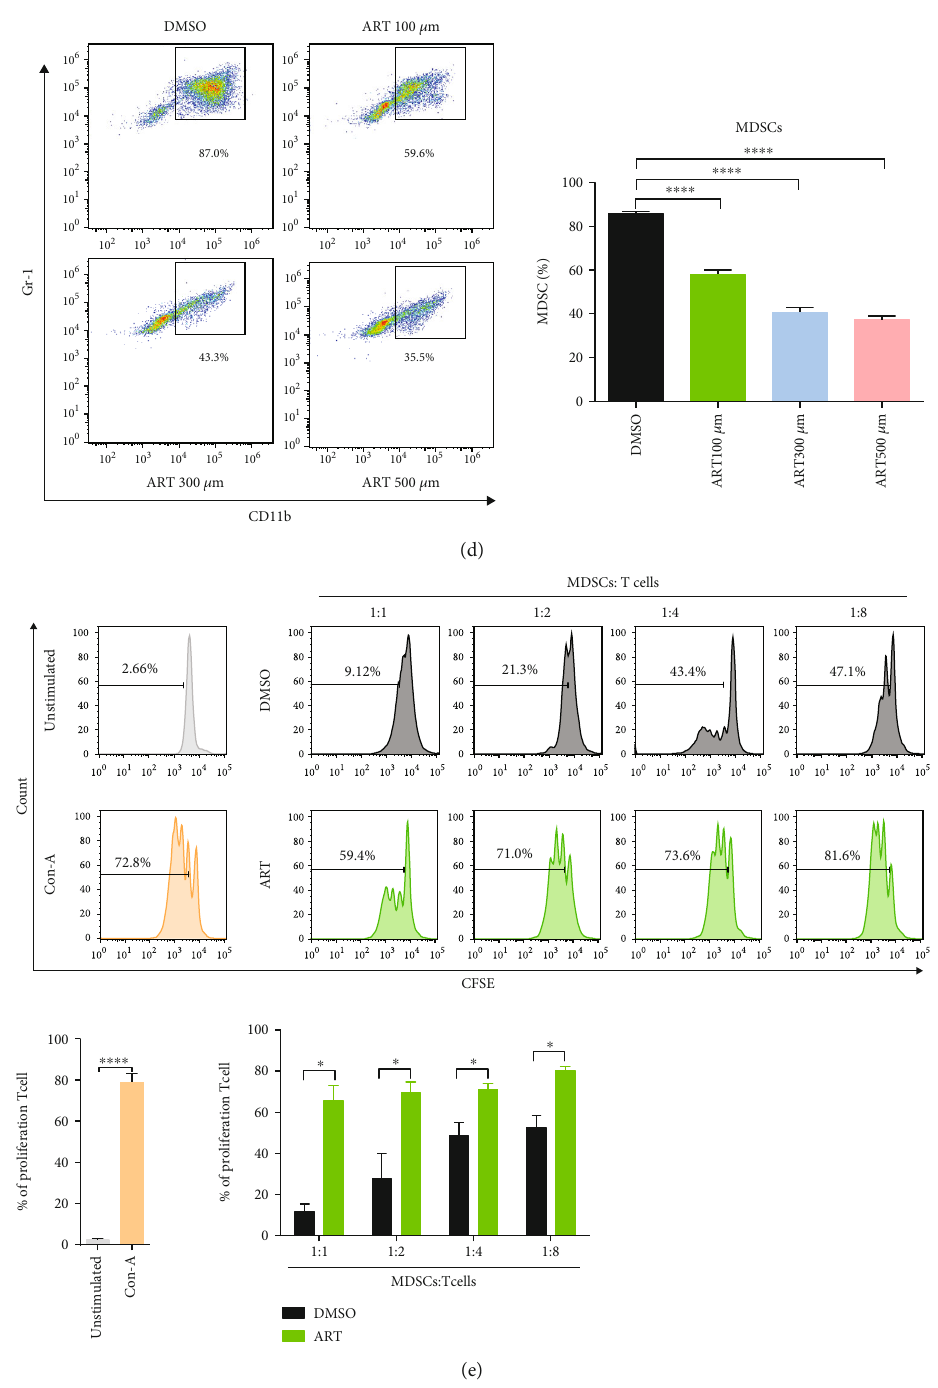
Figure 1: ART promotes MDSC apoptosis and inhibits the accumulation and immunosuppressive function of MDSCs. (a – e) Bone marrow (BM) cells isolated from wild-type C57BL/6 mice were cultured with GM-CSF and IL-6 for 3 days to generate in vitro BM-derived MDSCs and then were treated with di ff erent concentrations of ART (100 μ M, 300 μ M, and 500 μ M) for another 12 hours, and the solvent DMSO was used as the control. (a) The apoptosis levels of CD11b + Gr-1 + MDSCs were detected by fl ow cytometrical analysis. (b) The cleaved- caspase3, caspase3, p-RIPK3, and RIPK3 of CD11b + Gr-1 + MDSCs were detected by western blotting. (c) The DR5 mean fl uorescence intensity of CD11b + Gr-1 + MDSCs was detected by fl ow cytometrical analysis. (d) The proportion of CD11b + Gr-1 + MDSCs was detected by fl ow cytometric analysis. (e) Flow cytometry to purify CD11b + Gr-1 + cells from in vitro 100 μ M ART-treated BM-derived MDSCs and further cocultured CD11b + Gr-1 + MDSCs with Con A-stimulated CD3 + T cells isolated from the spleens of wild-type C57BL/6 at the 1 :1, 1 :2, 1: 4, and 1 :8 ratios to detect the percentages of proliferation T cells as tested by CFSE fl uorescence. Data are means ± SEM and are from a representative experiment of three (a – e) independent experiments. Unpaired Student ’ s < 0 : 05 , ∗∗∗ P < 0 : 001 , and ∗∗∗∗ P < 0 : 0001